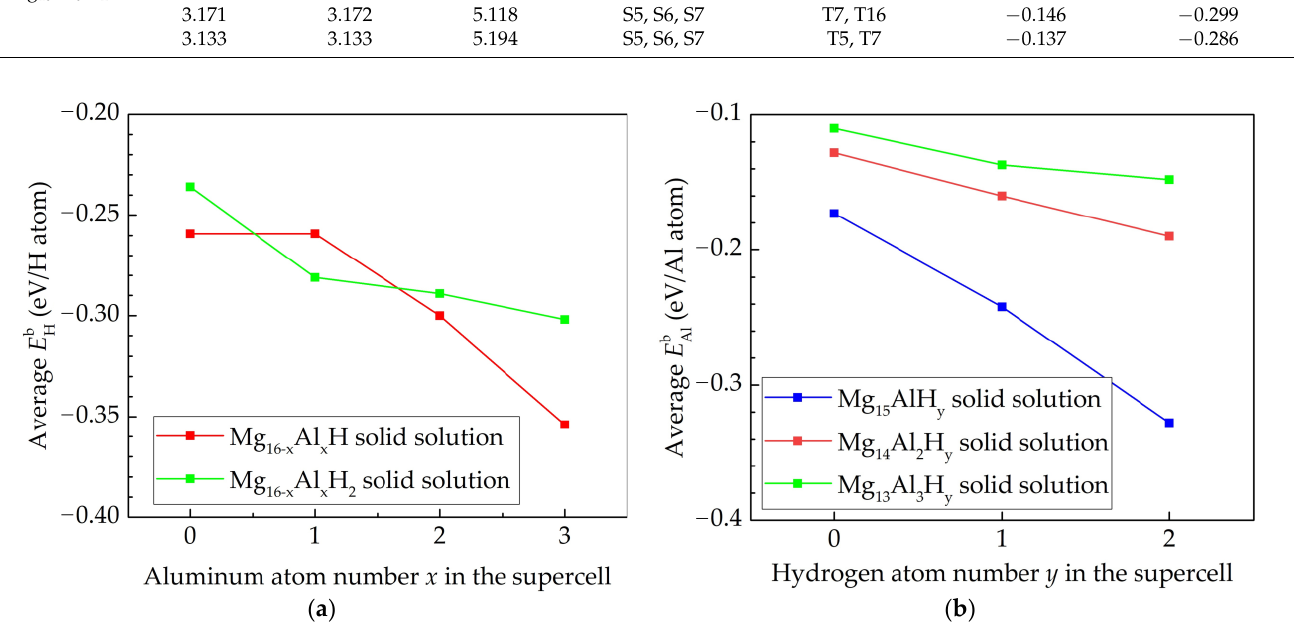
Figure 2. ( a ) Effect of Al atom on the average 𝐸 Hb of hcp Mg 16 − x Al x H y solid solution ( x = 0, 1, 2, 3, y = 1, 2); ( b ) effect of H atom on the average 𝐸 Alb of hcp Mg 16 − x Al x H y solid solution ( x = 1, 2, 3, y = 0, 1, 2).